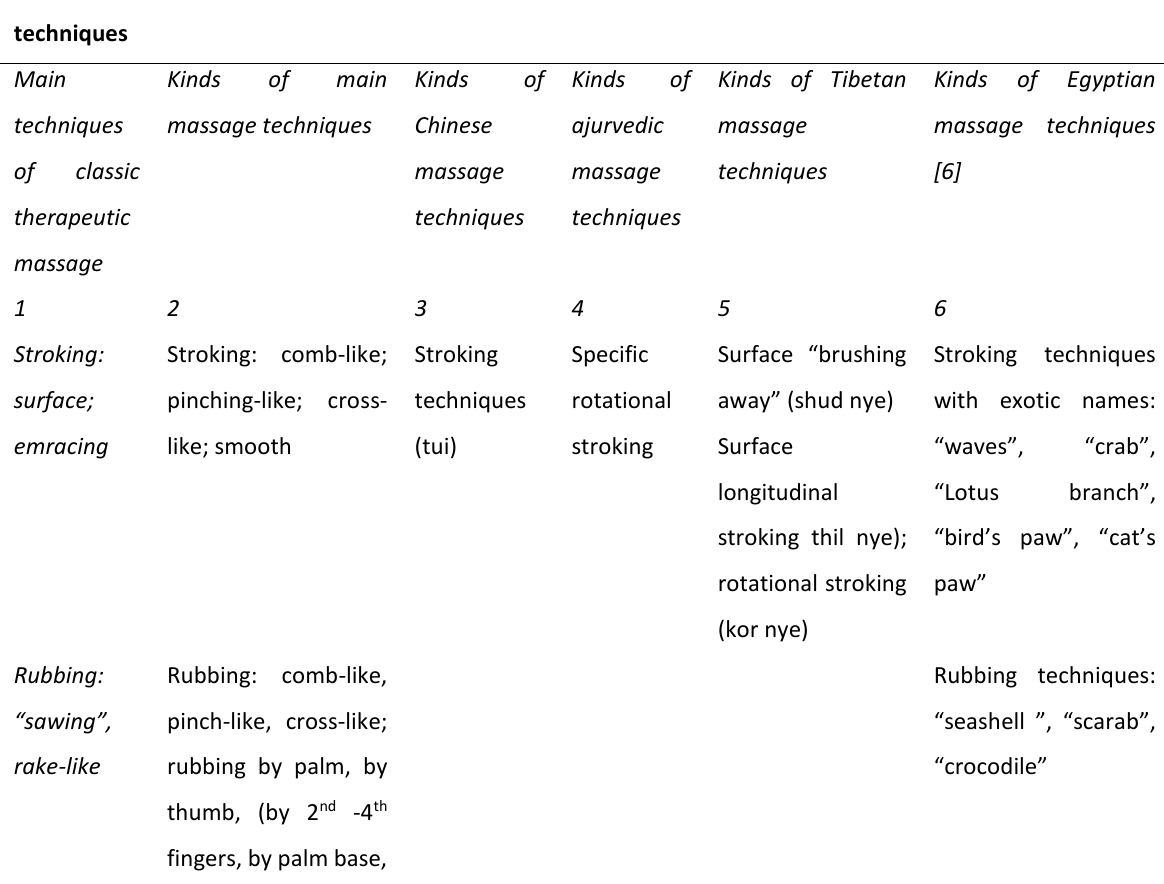
Table 1. Therapeutic massage with integrative technology Basic part of Additional variable part of western and oriental therapeutic massage therapeutic massage techniques